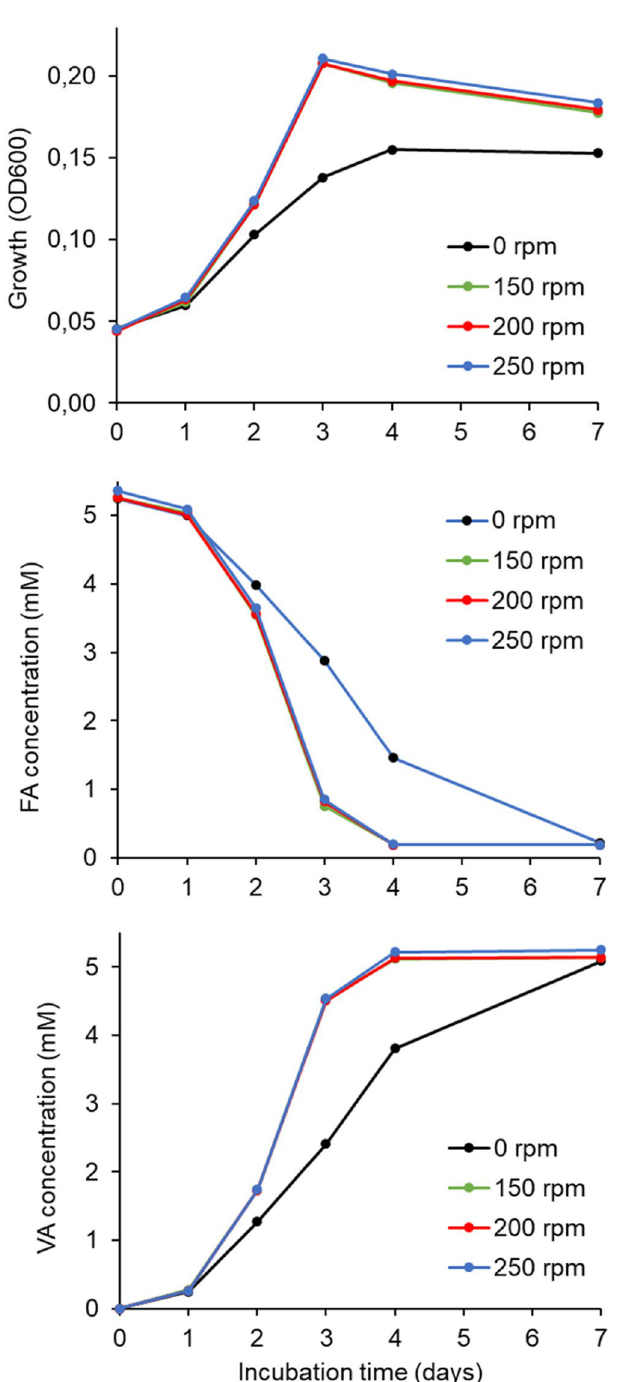
Fig. 1 Effect of agitation on growth (upper panel), degradation of 5 mM FA (middle panel), and VA production (lower pannel) by P. aromaticivorans AR20-38. Data represent mean values of three replicates (SDs <